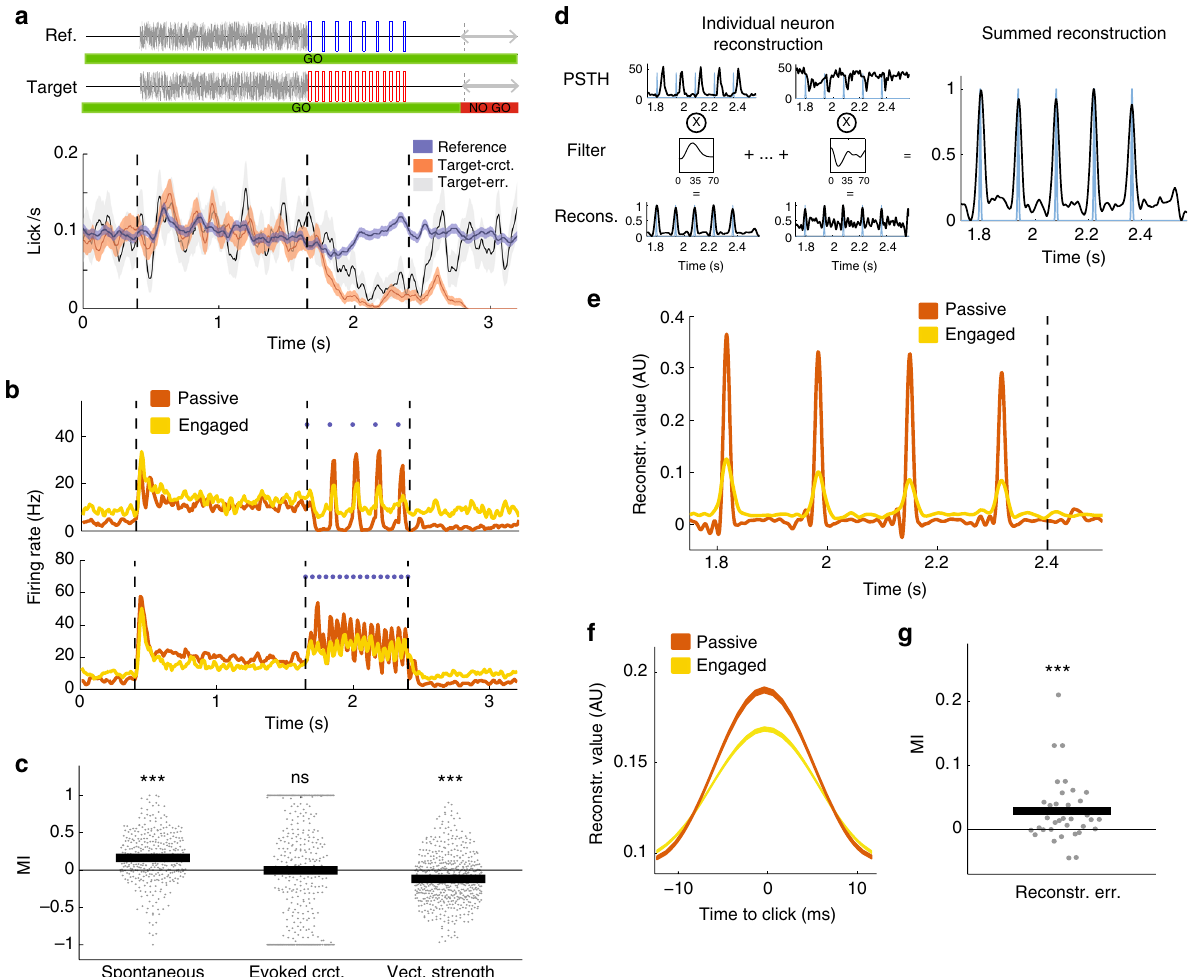
Fig. 1 Task structure and neural encoding of click times in A1. a Structure of the click-train discrimination task and average behavior of the two animals. Each sound sequence is composed of 0.4 s silence then a 1.25 s long white noise burst followed by a 0.8 s click train and a 0.8 s silence. On each block, the ferret is presented with a random number (1 – 7) of reference stimuli (top) followed by a target stimulus (bottom), except on catch trials with no target presentations. On blocks including a target, the animal had to refrain from licking during the fi nal 0.4 s of the trial, the no-go period, to avoid a mild tail shock (error bars are + / − SEM). b PSTH of two example units during reference sequences in the passive and engaged state. Note that, in the task- engaged state, the units show enhanced fi ring during the initial silent period of spontaneous activity and reduced phase locking to the stimulus. c Modulation index of each unit for spontaneous fi ring rate, spontaneous-corrected click-evoked fi ring rate, and vector strength showing higher spontaneous fi ring rates and lower vector strength in the task-engaged state. The vector strength was only calculated for units fi ring above 1 Hz and values for both reference and target are shown. SEM error bars are not shown because not visible at this scale: 0.017, 0.037, and 0.013, respectively (one-sample two- sided Wilcoxon signed-rank test with mean 0, n = 370, 574, 370, zval = − 8.99, p = 2.57e-19; zval = − 0.07, p = 0.94; zval = − 8.82, p = 1.16e-18; *** p < 0.001). d Schematic of stimulus reconstruction algorithm. Using PSTHs from half of the trials, a time-lagged fi lter is fi tted to allow optimal reconstruction of the stimulus for each individual unit. Individual reconstructions are summed to obtain a population reconstruction (far right). e Stimulus reconstruction from an example session showing degraded reconstruction in the task-engaged state. f Mean click reconstruction in passive and engaged states. g Modulation index of each session for stimulus reconstruction error. SEM error bar is not shown because it is not visible at this scale: 0.0014 (one- sample two-sided Wilcoxon signed-rank test with mean 0, n = 36; zval = − 3.4092, p = 6.51e-4; *** p <